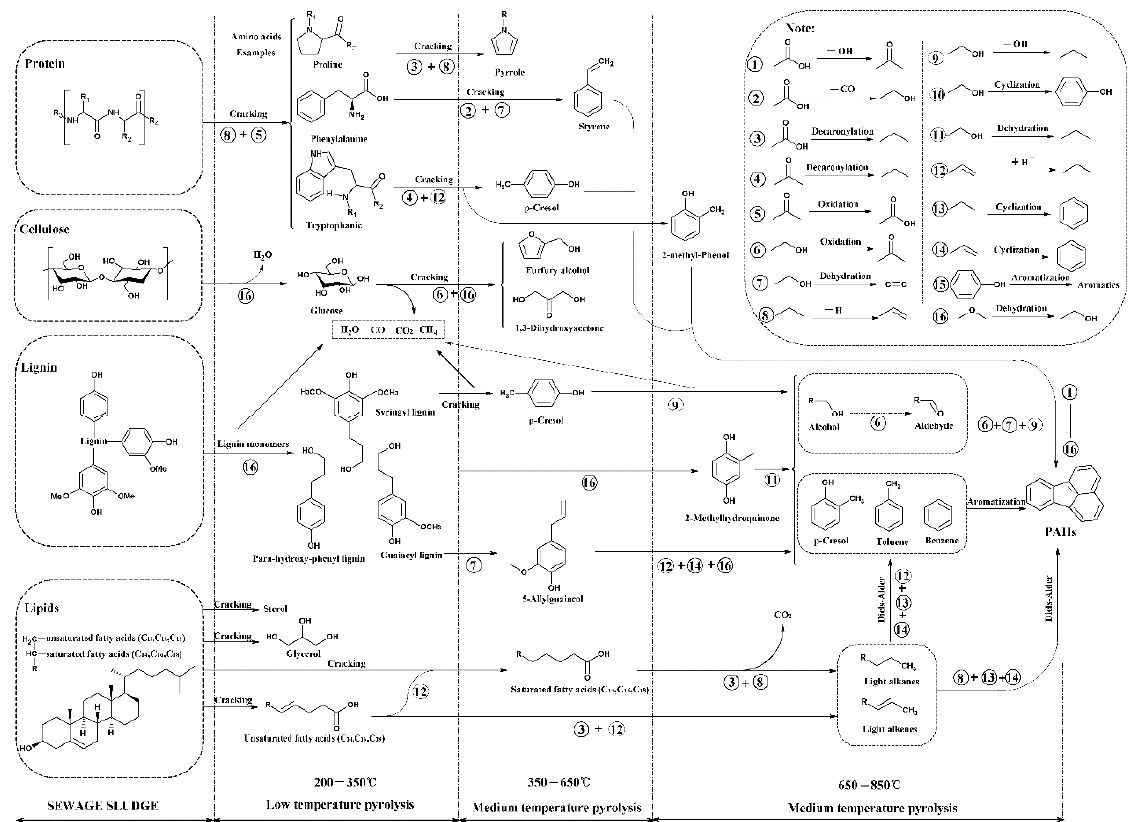
Figure 7. Possible carbon and oxygen-containing functional groups transformation pathways of sludge during